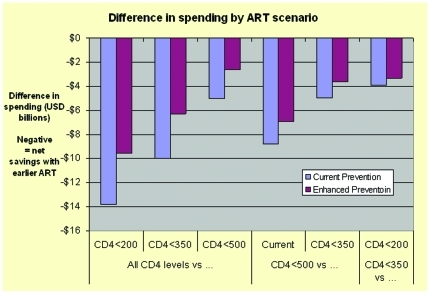
Difference in spending by ART scenario, 2010–2050 (discounted to 2010).This bar chart represents the difference in spending between different ART scenarios over 40 years (discounted to 2010). The ART scenario comparison is indicated on the horizontal axis, and the cost difference on the vertical axis (in millions). Negative numbers indicate fewer costs with more use of ART. Findings under current prevention impact are indicated in blue, and under enhanced prevention in maroon. The differences between scenarios are greater for current than enhanced prevention.